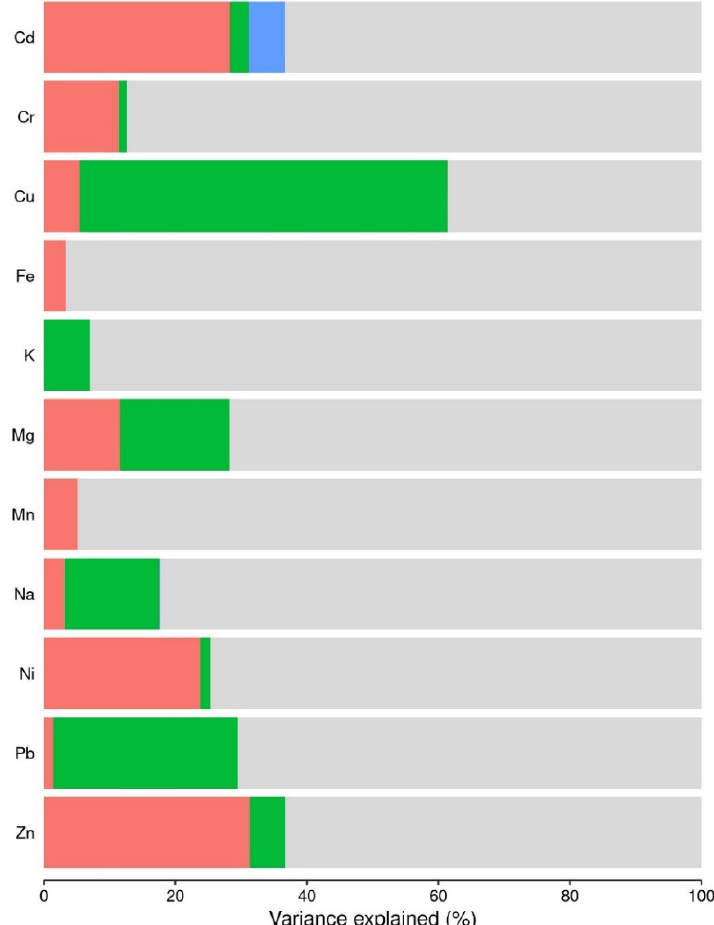
Figure 2. Barplots of the percentage of the variance of each PTE explained by the cultivar (red), the organ (green), and the fertilization (blue) in the linear random models, as well as by the model residuals (grey).